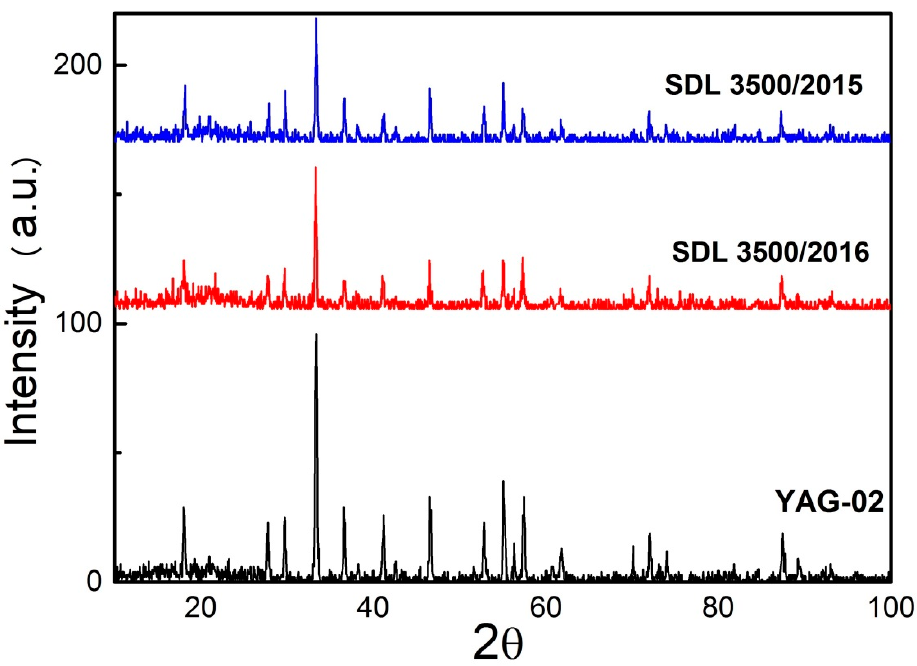
Figure 1. X-ray di ff raction (XRD) patterns of phosphor samples of di ff erent types synthesized under Figure 1. X-ray diffraction (XRD) patterns of phosphor samples of different types synthesized under di ff erent conditions. different conditions .